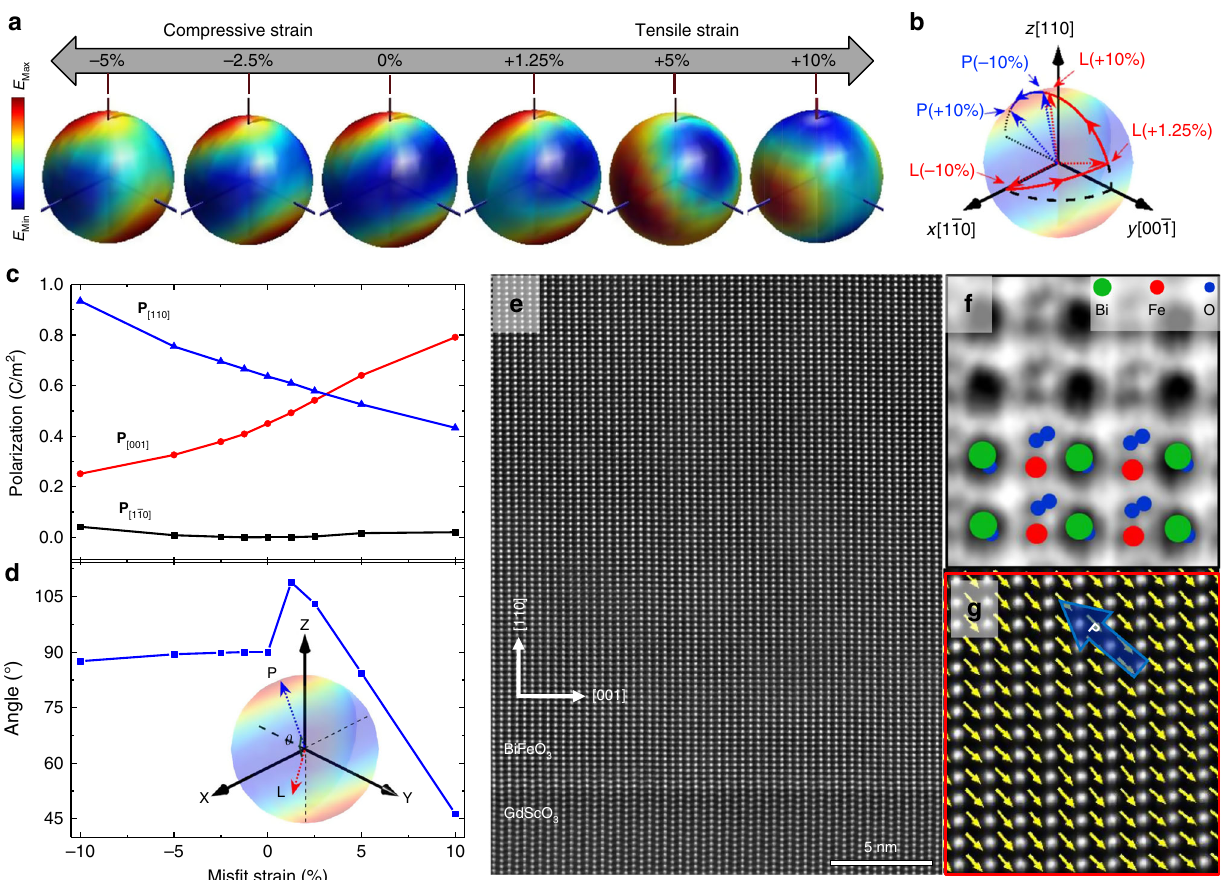
Fig. 3 Evolution of antiferromagnetic-spin and polarization with strain. a Three-dimensional representation of the evolution of the magnetic energy landscape under various strain states. The color in the representation indicates the total energy when the antiferromagnetic-spin axis L points in that direction wherein cool and warm colors represent low and high energy, respectively, and thus easy and hard axes, respectively. b Summary of the evolution of antiferromagnetic-spin axis L (red arrow) and polarization P (blue arrow) with strain from fi rst-principles calculations. c The three components of the polarization as a function of mis fi t strain from the fi rst-principles calculations. d The angle θ between the polarization vector and the antiferromagnetic- easy axis as a function of mis fi t strain. e High-resolution high-angle annular dark fi eld-scanning transmission electron microscopy (HAADF-STEM) image of a 70 nm BiFeO 3 /GdScO 3 (010) O heterostructure. f Bright fi eld-scanning transmission electron microscopy (BF-STEM) image of the same heterostructure showing the Fe cation and O anion displacement details. Direct imaging of all species in the BF-STEM image enables direct extraction of the polar distortions. g Fe-cation displacement vector maps relative to its two neighboring Bi cations; the fi lms are found to exhibit uniform structural distortion as noted, indicating that the polar direction of the fi lm is uniform and close to the expected 〈 111